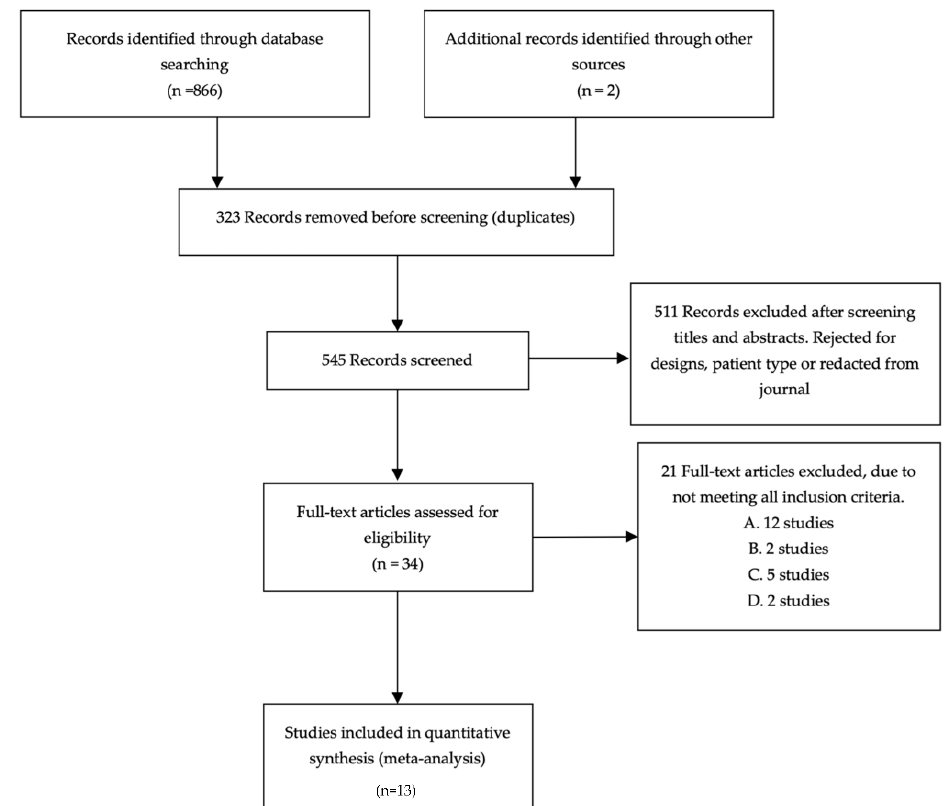
Figure 1. Preferred Reporting Items for Systematic Reviews and Meta-Analyses (PRISMA) flow diagram for study inclusion. Inclusion criteria A. Included athletes with existing, or under treatment for, lower-limb musculoskeletal injuries. B. Focused on children <10 years old. C. Includes non-athletic or participants who do not regularly participate in sports. D. Article was not in English.